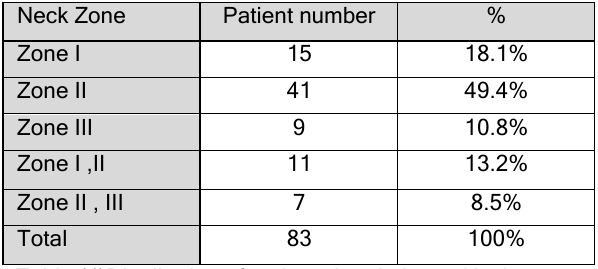
Table (4)Distribution of patients in relation to Neck Zones Of the 83 patients who sustained PNI and were evaluated with various clinical and